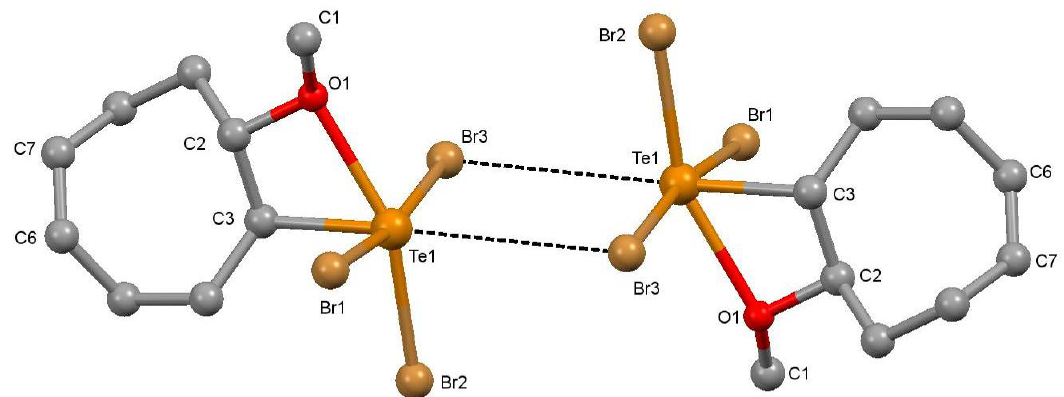
Figure 2. Te—( µ -Br) centrosymmetric dimers of 3 . Hydrogen atoms are omitted for clarity. Selected distances ( Ǻ ): (in- tramolecular); Br(1)-Te(1) 2.6562(5), Te(1)-Br(2) 2.5121(7), Te(1)-Br(3) 2.6880(5), Te(1)-O(1) 2.416(3), (intermolecular) Br(3)-Te(1) 3.7389(6).